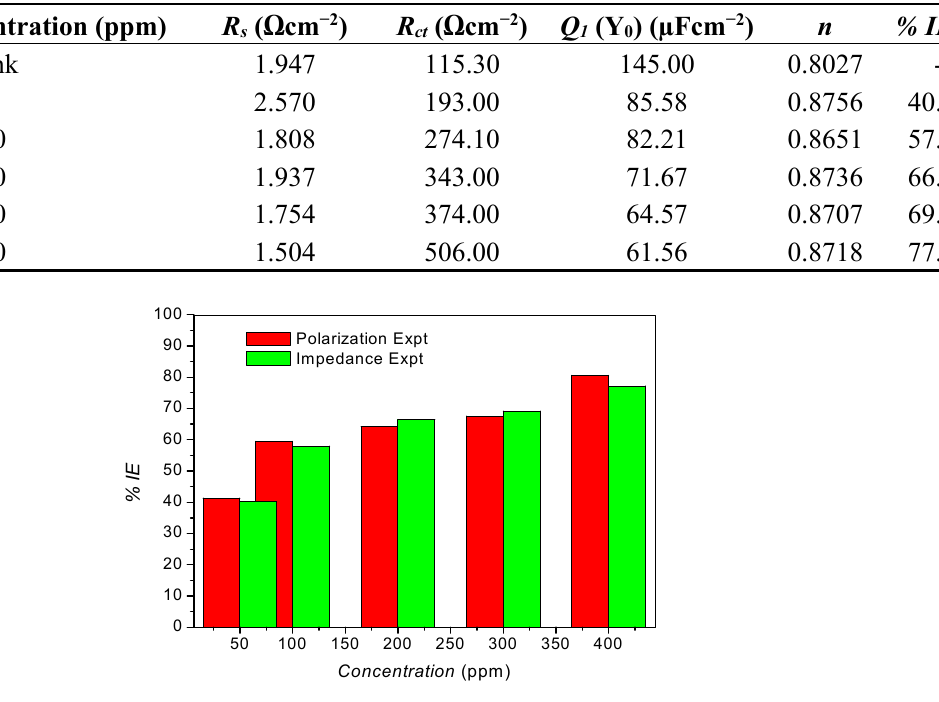
Table 3. Fitted parameters from electrochemical impedance spectroscopy.